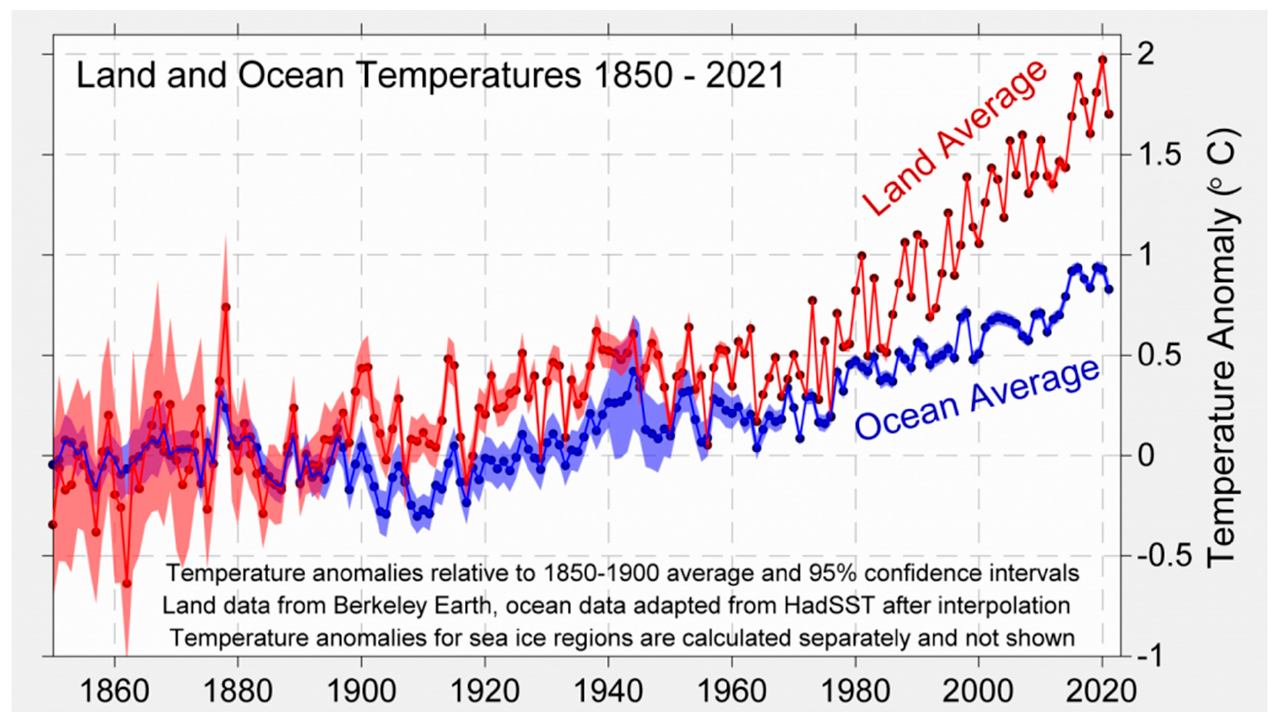
Figure 2. Berkeley Earth graph showing land temperatures increasing faster than ocean tempera- tures.